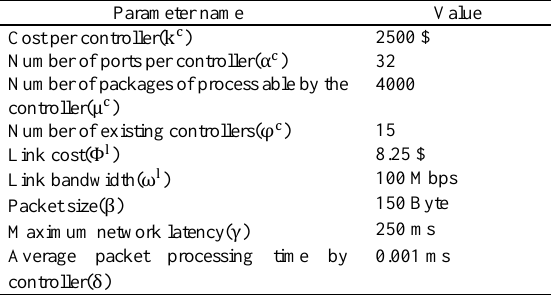
Value Parameter name